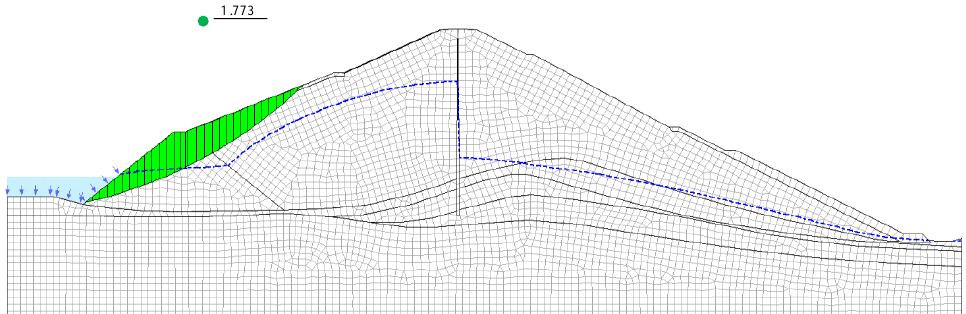
Figure 3. The most dangerous sliding surface of upstream dam slope before sudden drop of water level.